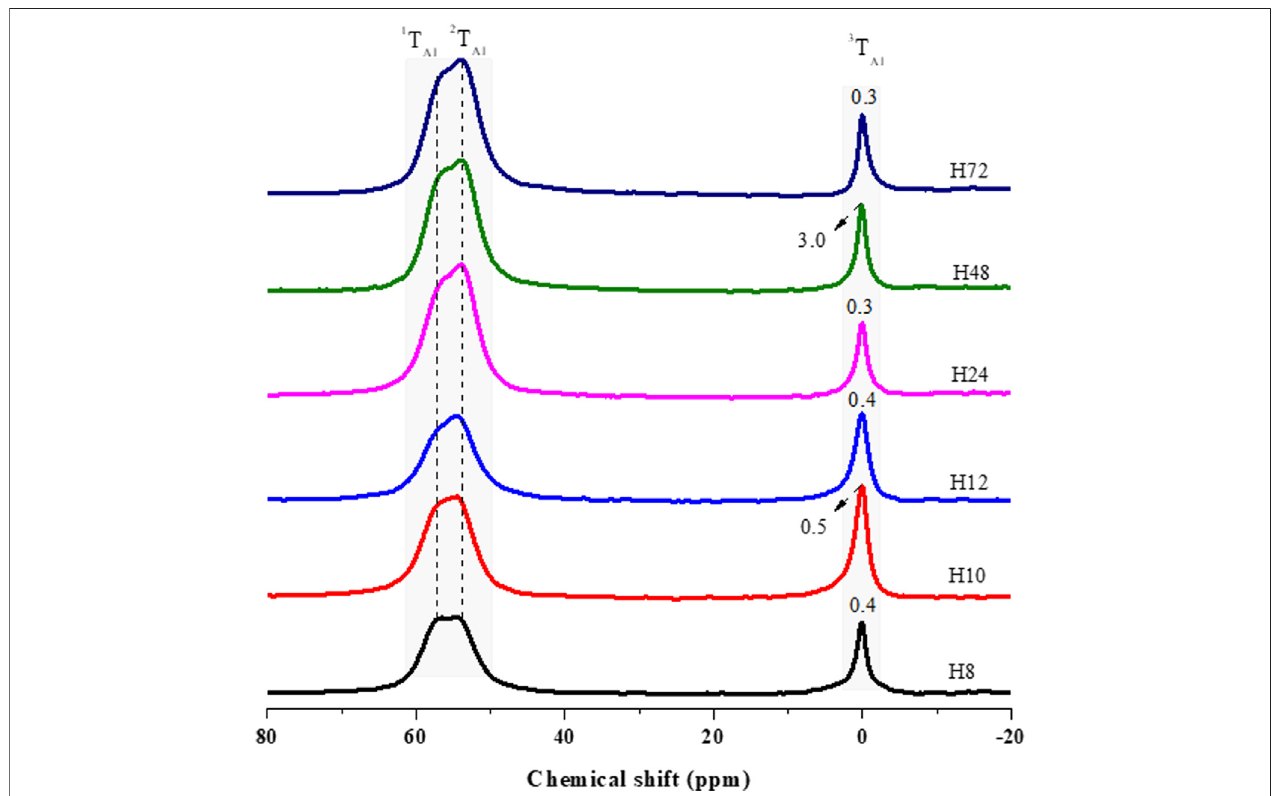
FIGURE 6 | 27 Al MAS NMR analysis of as-synthesized HBEA zeolites produced from CFA nanosilica extract at different hydrothermal times.